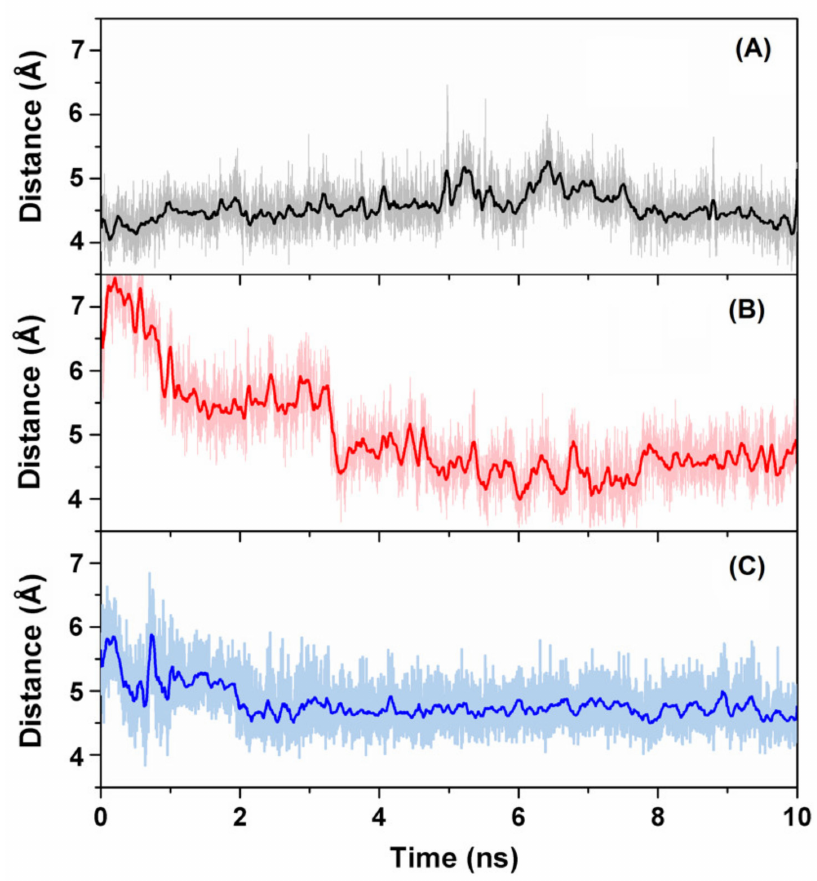
Figure 7. Distance between the double ring in the quercetin moiety of rutin and the catalytic residues His41/Cys145 of 3CLpro in MD simulation. ( A ) Distance with respect to the imidazole ring of His41, for the most favorable docking pose; ( B ) Separation from the side chain ring of His41, starting from a docking pose sub-optimally accommodated in the binding pocket; ( C ) Separation from the side chain of Cys145 (same simulation run as in